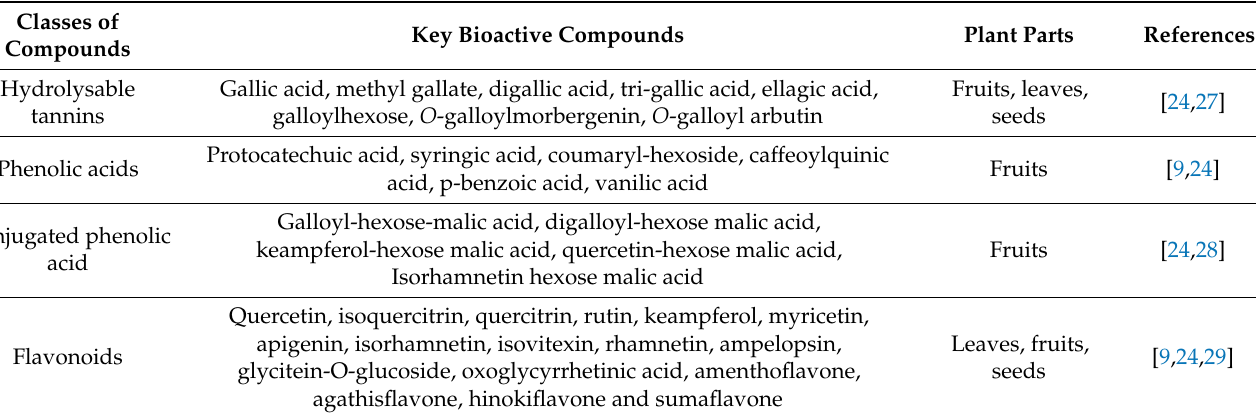
Table 3. Summary of key phytochemicals from Rhus coriaria